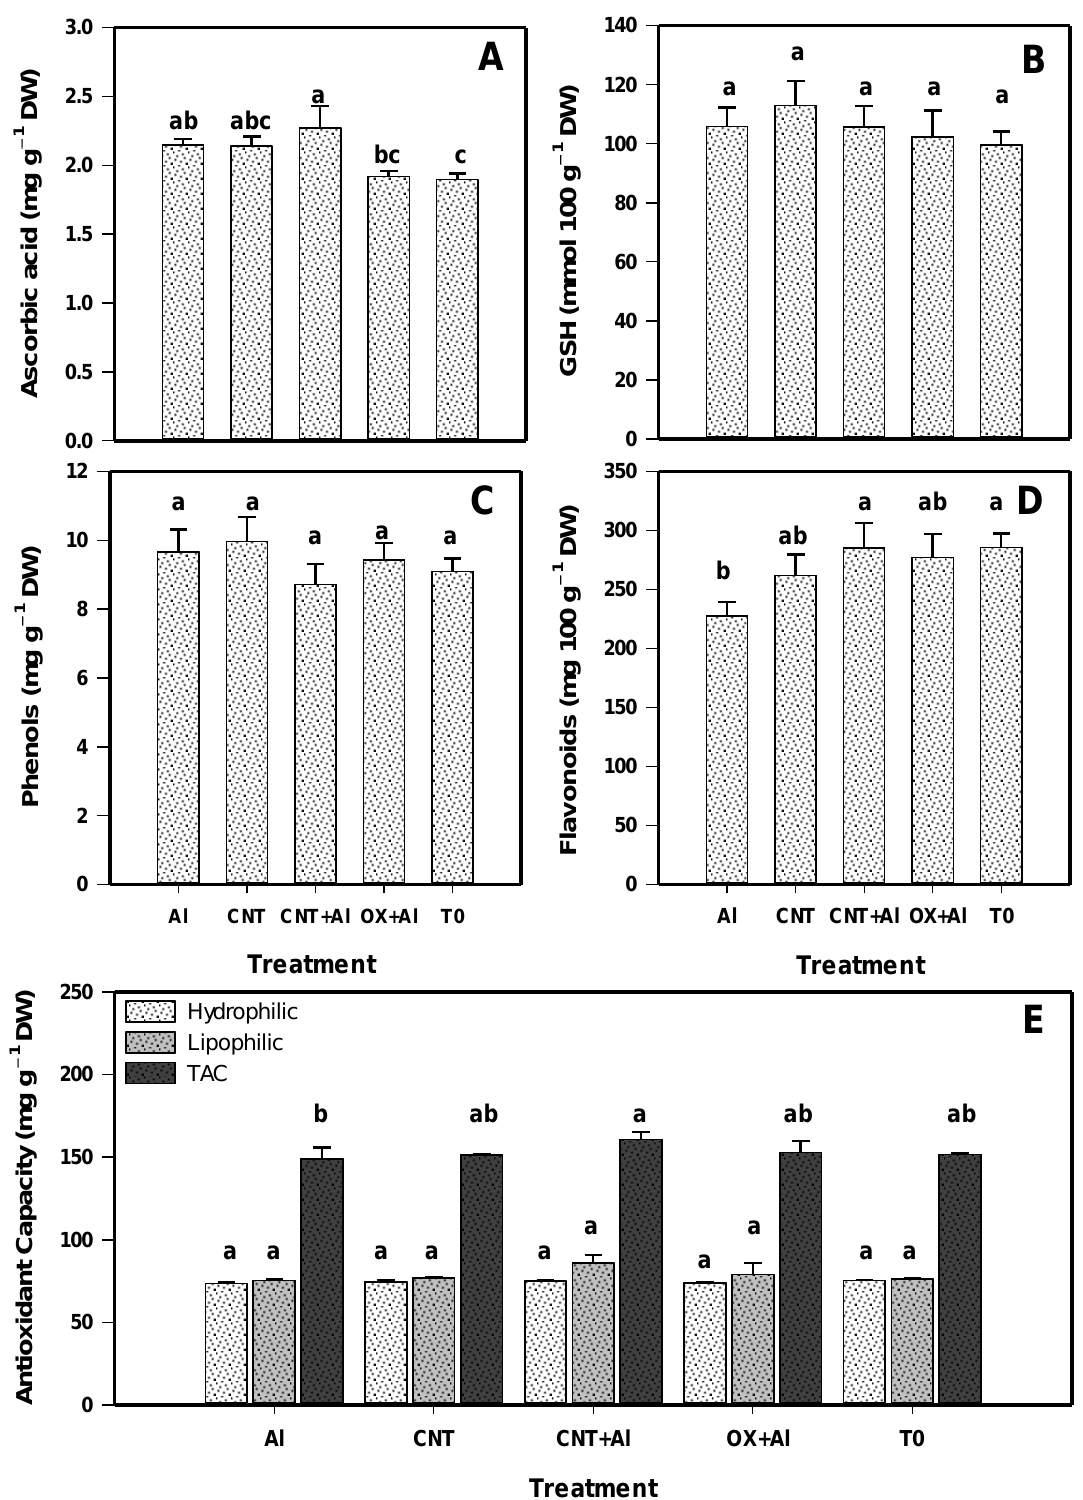
Figure 5. Ascorbic acid ( A ), glutathione (GSH) ( B ), phenols ( C ), flavonoids ( D ), and antioxidant capacity ( E ) in leaves of tomato plants. Al: Positive control inoculated with A. solani ; CNT: Carbon nanotubes; OX: Commercial control; T0: Control. Different letters indicate significant differences between treatments according to the least significant difference of Fisher test (α = 0.05). N = 5 ± standard error.